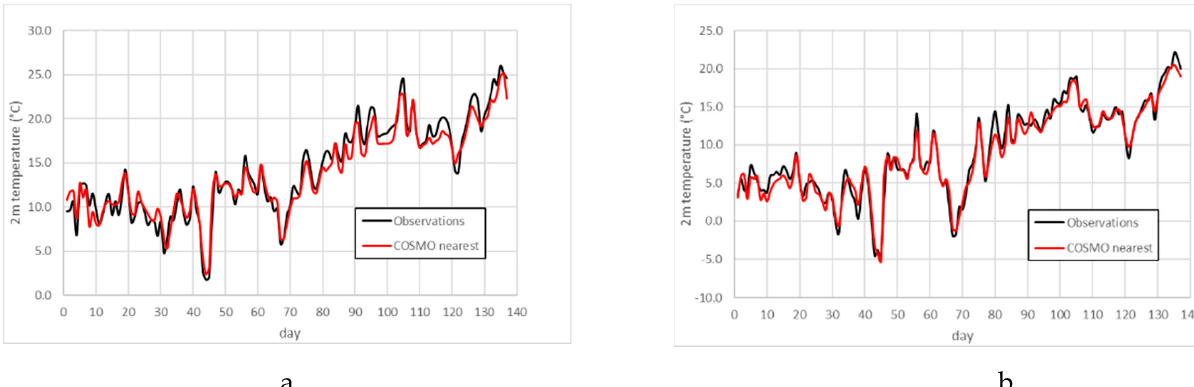
Figure 4. Time series of daily t2m (°C) at Napoli Capodichino ( a ) and Montemarano ( b ) over the considered period: observational and model data for the nearest grid point. Table 1. Mean, maximum positive and maximum negative temperature bias (°C) and RMSE (°C) of